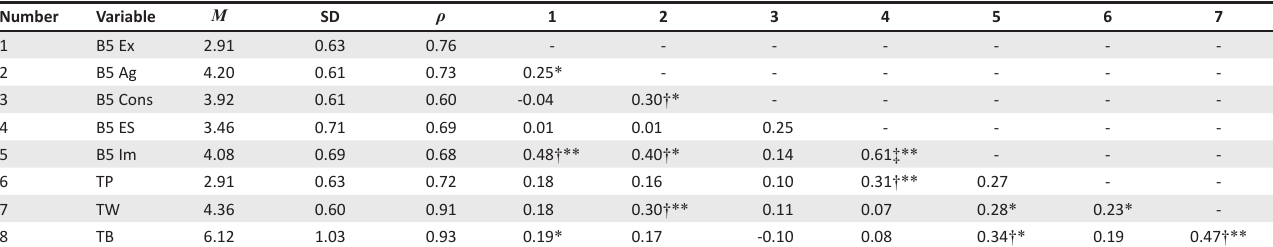
TABLE 2: Descriptive statistics, reliability coefficients and correlations. Number